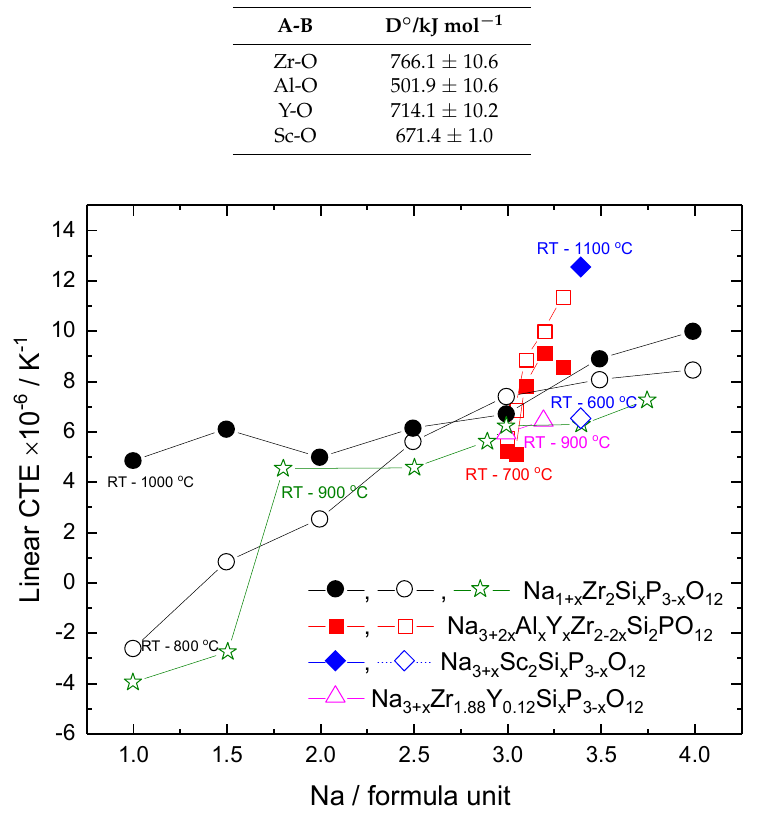
Figure 4. The CTE data of NAYZSiP x (red squares) in comparison to other NaSICON materials previously reported in the temperature range as indicated in the figure. Black circles represent Na 1+ x Zr 2 Si x P 3− x O 12 [8], blue diamonds Na 3+ x Sc 2 Si x P 3− x O 12 [10], green stars Na 1+ x Zr 2 Si x P 3− x O 12 [19], and pink triangles Na 3+ x Y 0.12 Zr 1.88 Si x P 3− x O 12 [25]. Filled and empty symbols represent data obtained from HT-XRD and dilatometry, respectively.